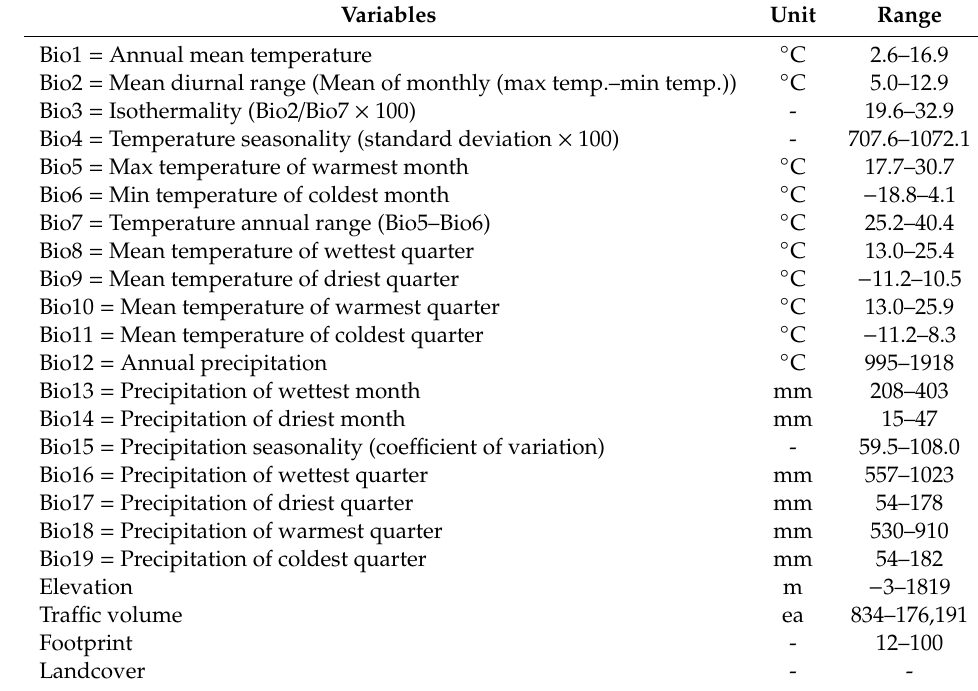
Table 1. A list of the 23 variables, including 19 bioclimatic variables, used in the prediction of the current distribution of R. shantungensis